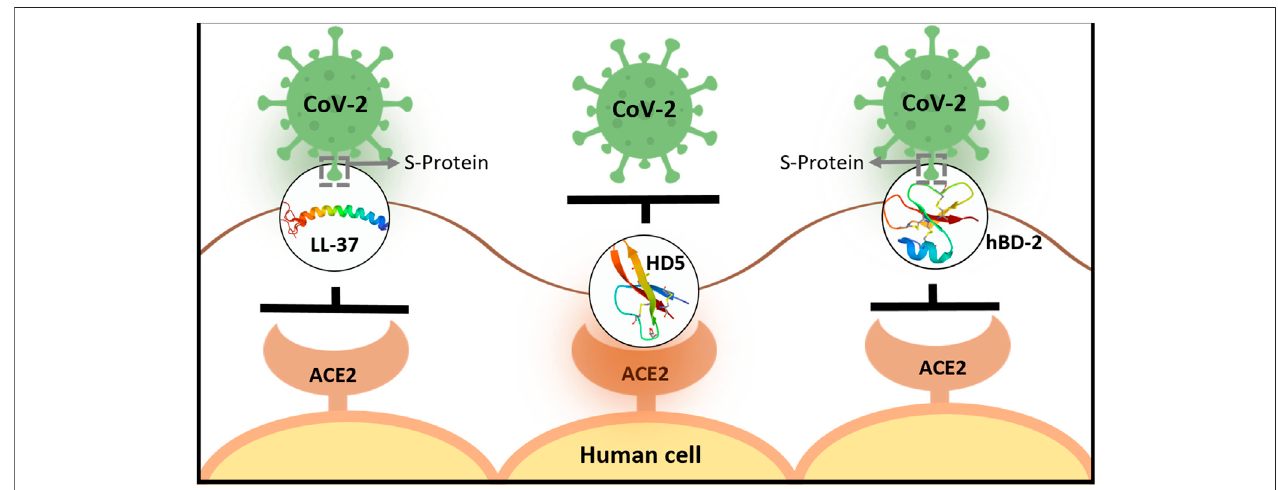
FIGURE 1 | Schematic representation showing differential binding of human AMPs to SARS-CoV-2 S protein or ACE2 on cell surfaces. LL-37 and hBD-2 bind to SARS-CoV-2 S protein and inhibit its binding to ACE2 on the cell surface prior to entry (Lokhande et al., 2020; Roth et al., 2020; Wang C. et al., 2021; Zhang L. et al., 2021). In contrast, HD-5 binds to ACE2 to inhibit viral entry (Wang et al., 2020a) [LL-37 has also been shown to bind ACE2, however, with lower af fi nity than S-RBD (Wang C. et al.,